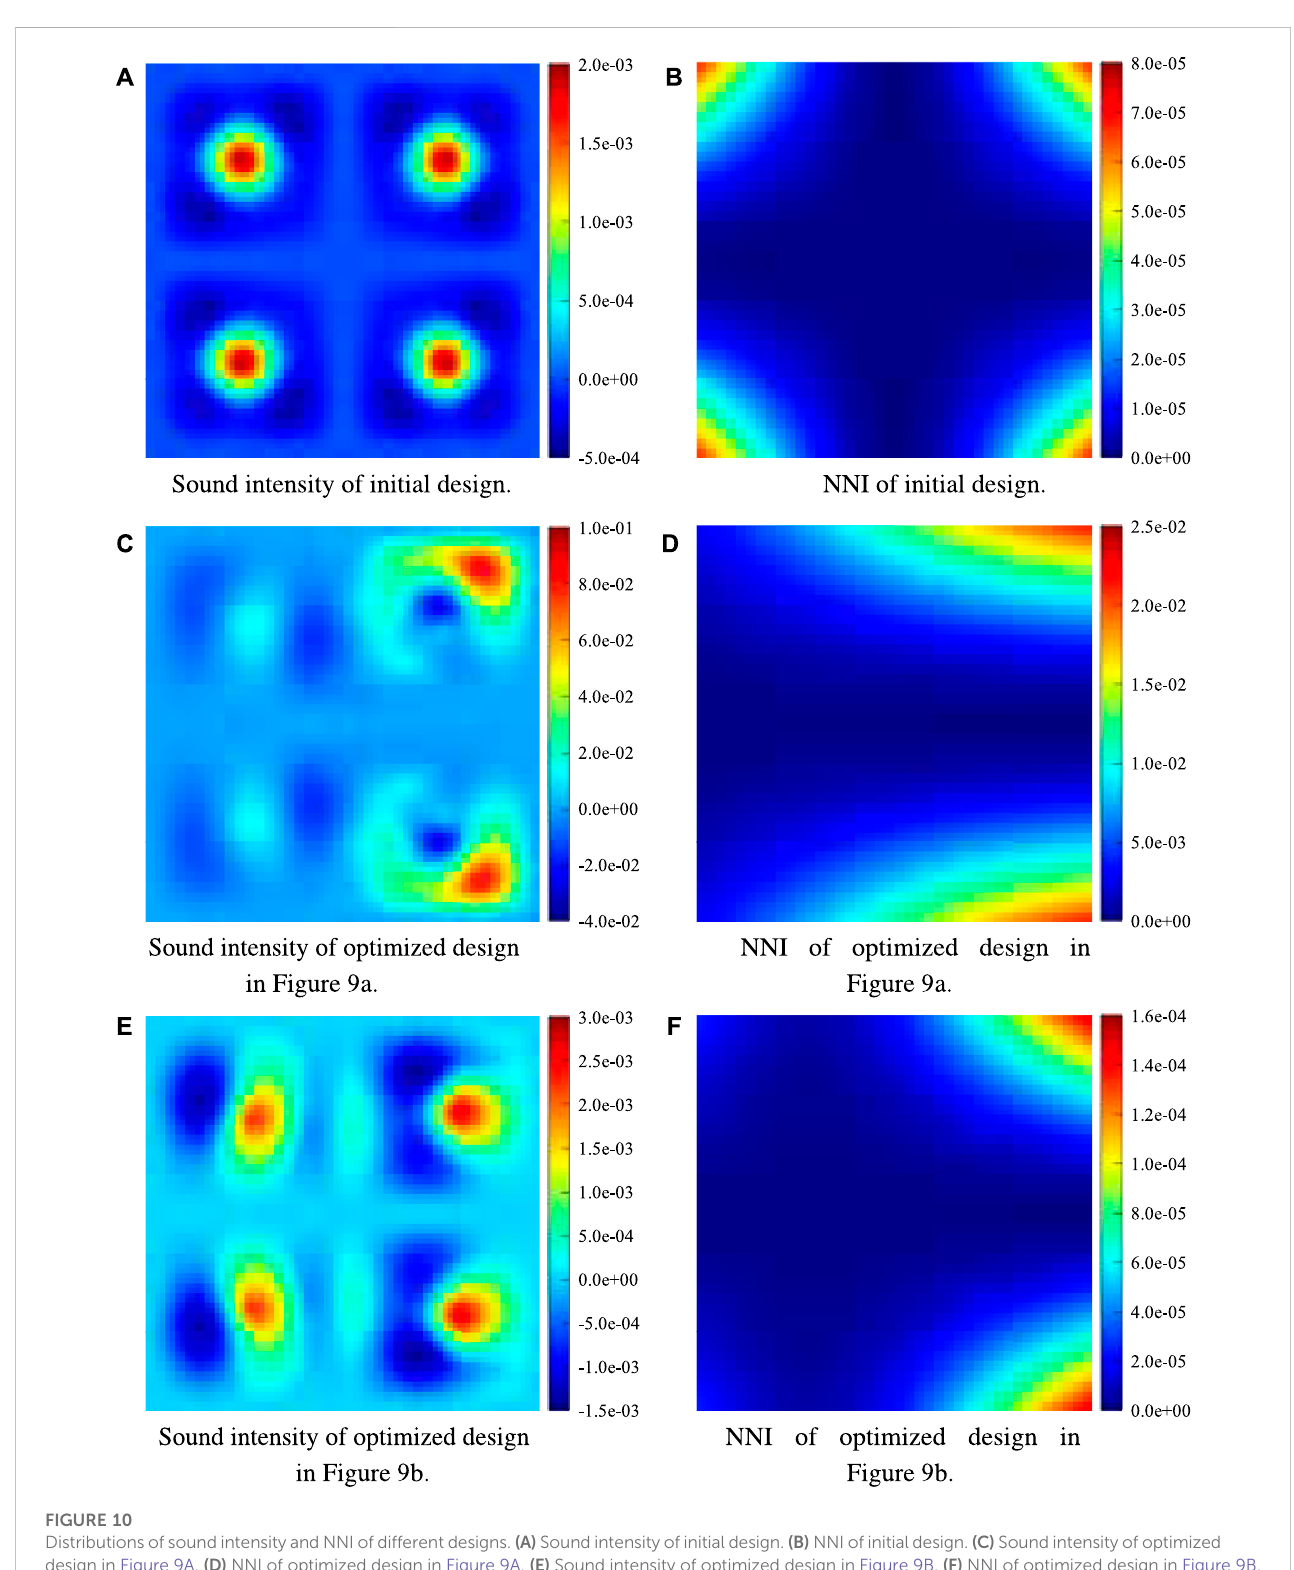
FIGURE 10 DistributionsofsoundintensityandNNIofdifferentdesigns. (A) Soundintensityofinitial design. (B) NNIofinitial design. (C) Soundintensityofoptimized design in Figure 9A. (D) NNI of optimized design in Figure 9A. (E) Sound intensity of optimized design in Figure 9B. (F) NNI of optimized design in Figure